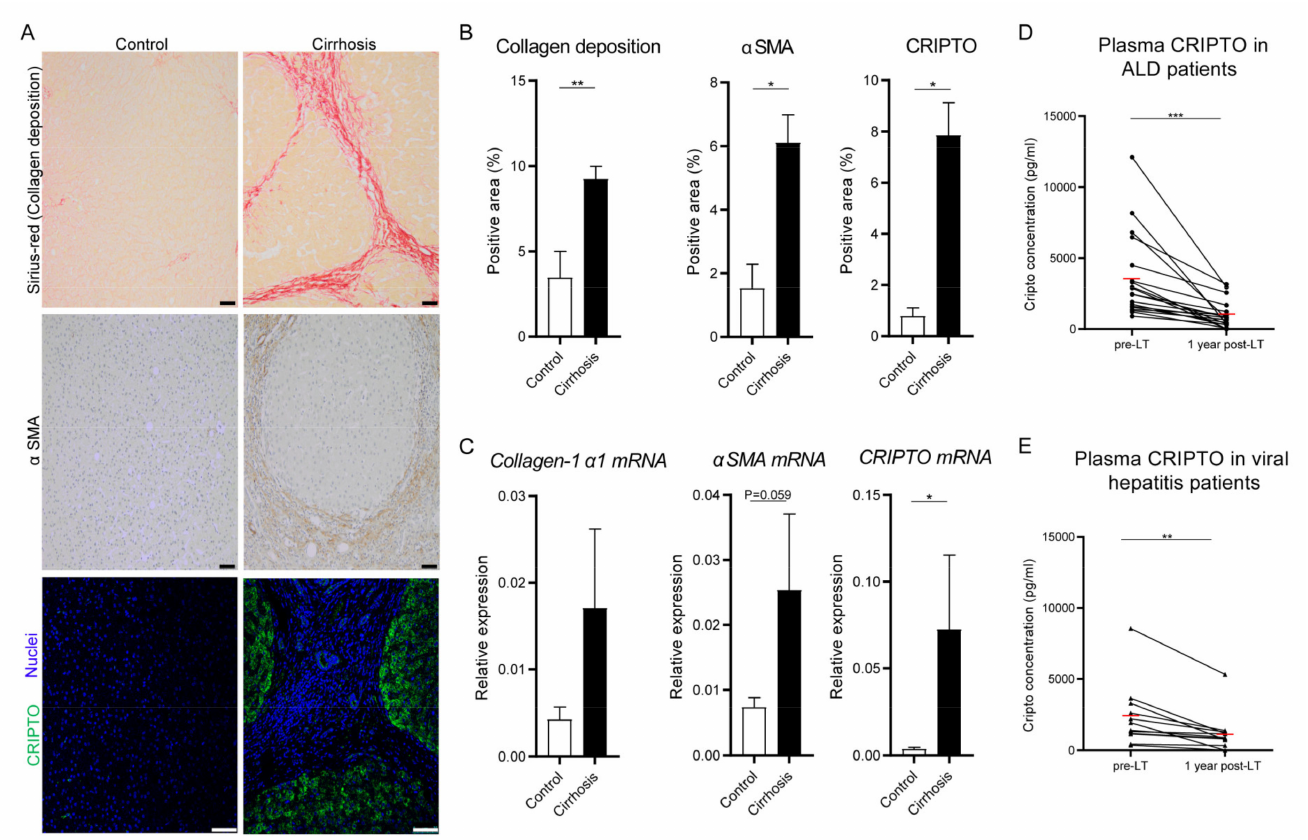
Figure 1. CRIPTO expression in patients with end-stage liver cirrhosis. Liver tissue samples of patients with ALD or virally induced liver cirrhosis ( N = 19) and controls ( N = 5) were randomly selected to evaluate CRIPTO expression. ( A ) Representative pictures of control and cirrhotic liver tissue stained for collagen deposition (Sirius-Red, scale bars 50 µ m), α SMA (scale bars 50 µ m), CRIPTO (green), and Nuclei stained with DAPI (blue) scale bars 75 µ m). ( B ) Quantification of Sirius-red, α SMA, and CRIPTO staining (mean ± SEM). All samples were derived from the same experiment, and the staining and quantification were performed once per tissue sample. ( C ) The mRNA expression levels of Collagen-1 α 1 , α SMA , and CRIPTO normalized to β -actin (mean ± SEM); * p ≤ 0.05 ** p ≤ 0.01. Tissues were derived from one experiment and measured with three technical repeats. N = 5–10 samples per group. ( D , E ) CRIPTO levels in plasma decreased after liver transplantation (LT) in different aetiological sub-cohorts. CRIPTO levels in pre- and post-LT paired plasma samples of patients suffering from ( D ) ALD- ( N = 19) or ( E ) virally ( N = 12) induced liver cirrhosis. Mean group levels are indicated by a red line; ** p ≤ 0.01 *** p ≤ 0.001. All samples were measured in